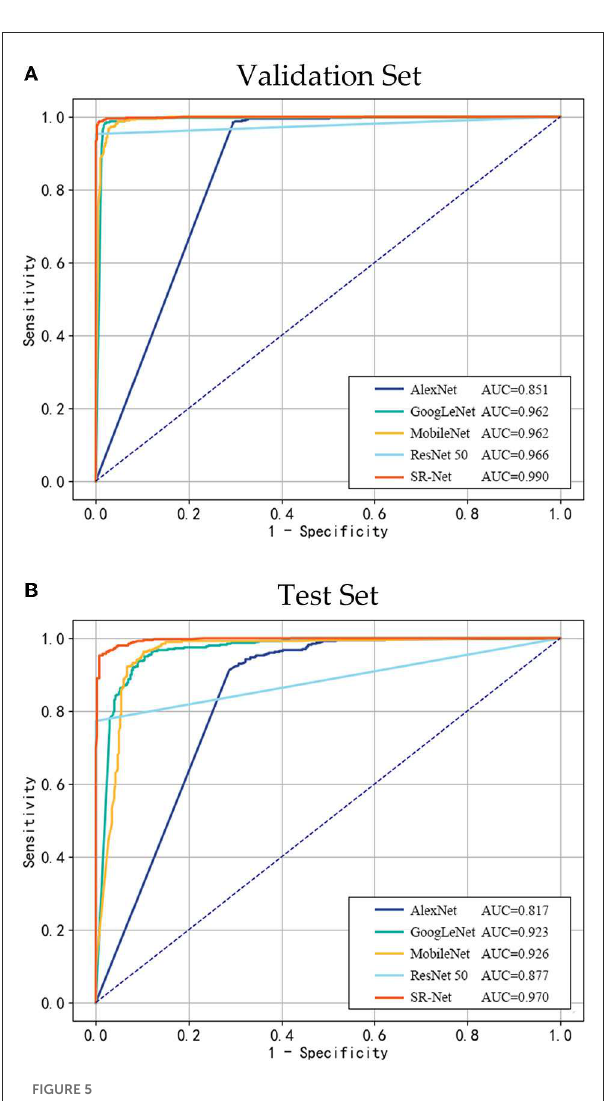
FIGURE5 ROC curves and AUC for AlexNet, ResNet50, MobileNet, GoogLeNet, and SR-Net models on the validation set (A) and test set (B)